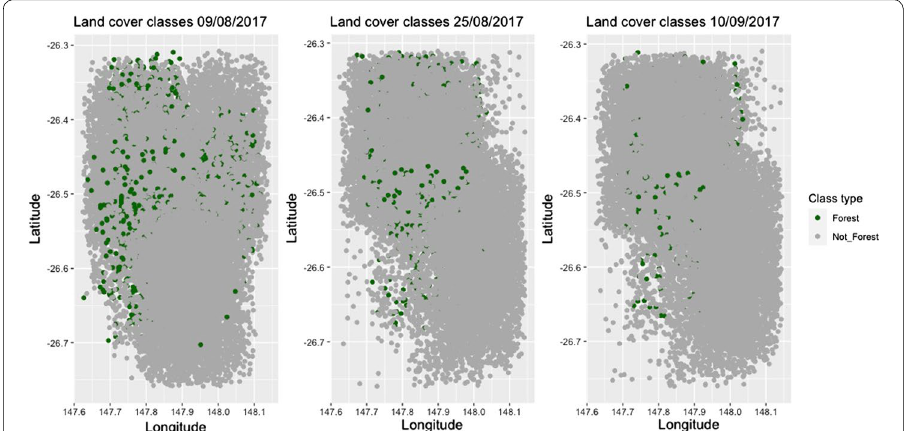
Fig. 14 Plot of the true land cover classifications for the same sample of neighbourhoods in Area 2 across three time points, plotted by their latitude and longitude. The points are jittered by 0.1 to make interpretation easier as they are spatially close together. Forest is shown in green and not forest in